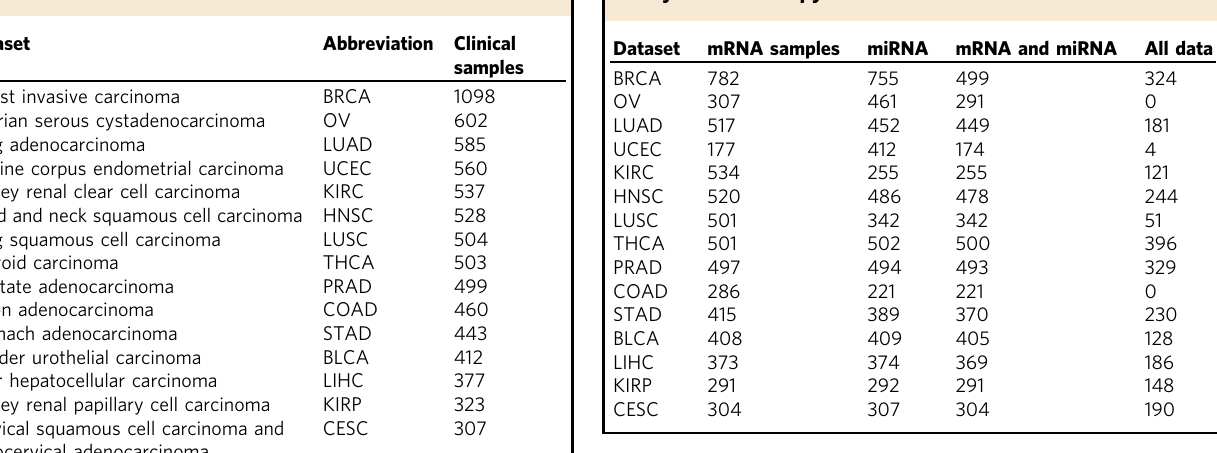
Table 3 Counts of samples with miRNA, mRNA,